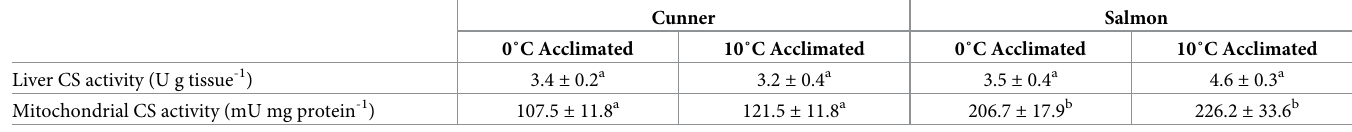
Table 2. CS activity in isolated mitochondria and liver from 0 and 10˚C acclimated cunner and salmon. Letters indicate a significant difference between groups; as determined by a 2-way ANOVA followed by Newman-Keuls post-hoc tests. There were no significant acclimation effects. Values are means ± s.e.m., N =